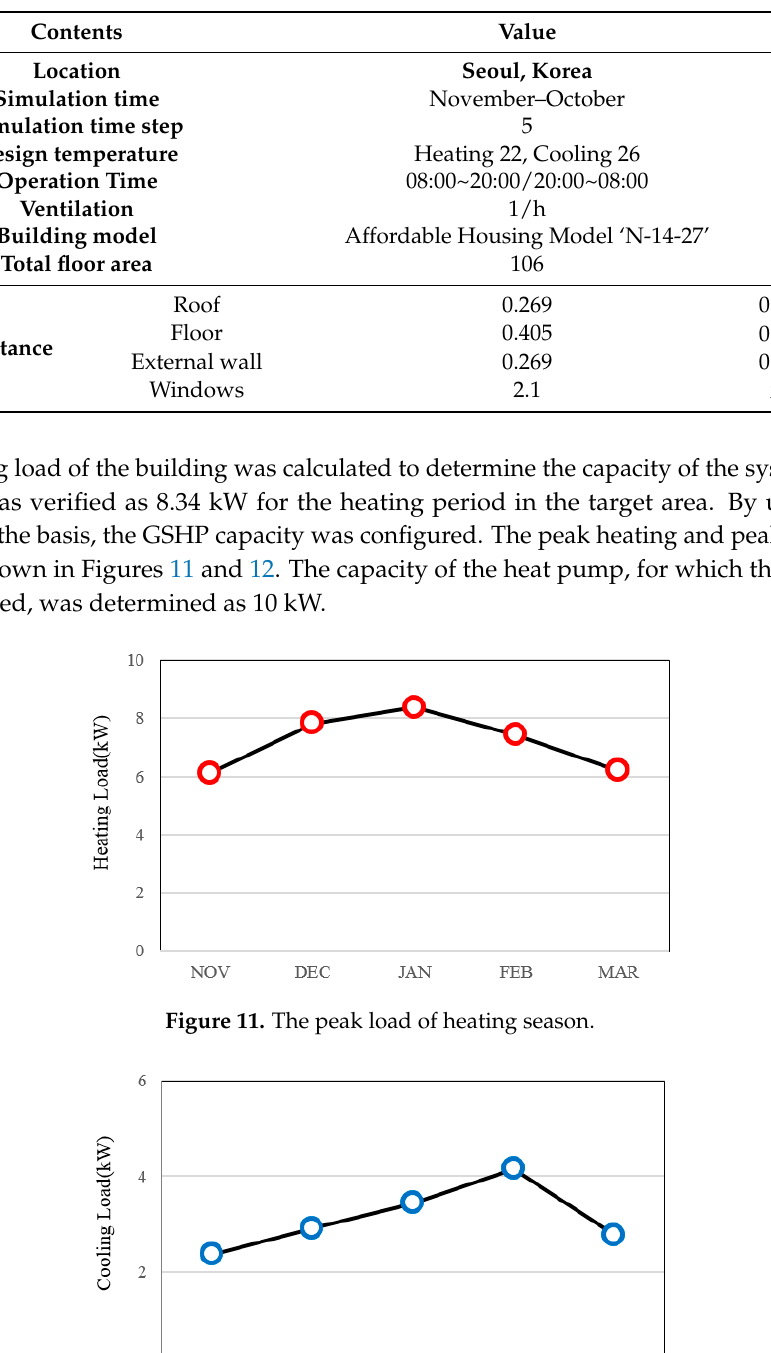
Table 1. Basic simulation design parameter.